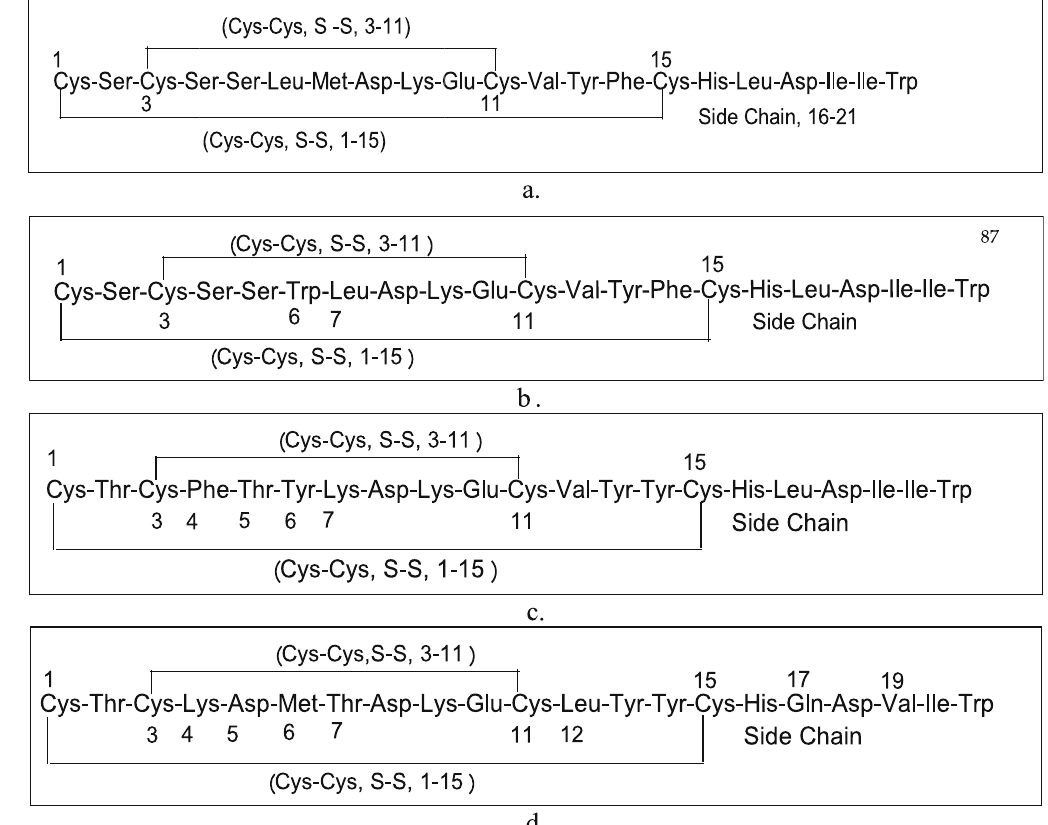
Figure 1: ETs; ( a ) ET - I, ( b ) ET - II, ( c ) ET - III, and ( d ) SRT -